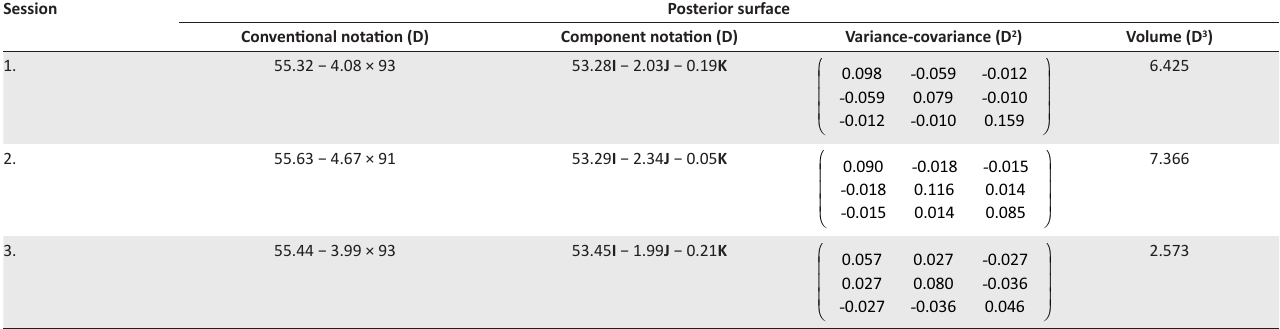
TABLE 2: Means in conventional and component notation, variance-covariance matrices and 95 % distribution ellipsoid volumes for the posterior surface corneal curvature measurements are indicated. Session Posterior